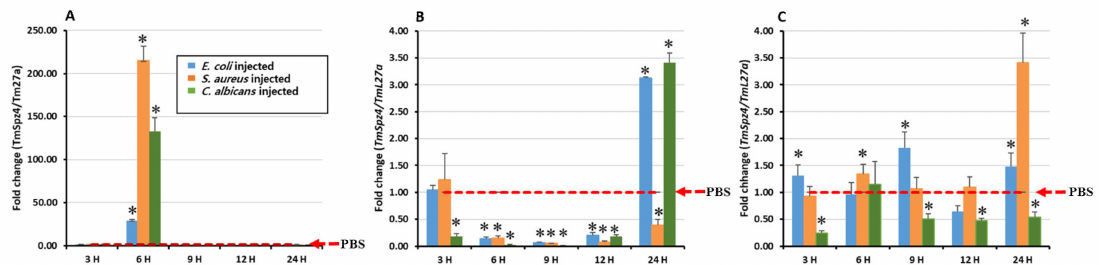
Figure 3. Induction patterns of TmSpz4 in different T. molitor larval tissues. Temporal expression was analyzed in the hemocytes ( A ), fat body ( B ), and gut ( C ) of young larvae at 3, 6, 9, 12, and 24 h post-injection with E. coli (10 6 cells / µ L), S. aureus (10 6 cells / µ L), or C. albicans (5 × 10 4 cells / µ L). Twenty young mealworm larvae were used for each time point. TmSpz4 expression levels were normalized to those in PBS-injected controls. T. molitor 60S ribosomal protein L27a ( TmL27a ) was used as an internal control. The dotted red line indicates PBS injection control. Asterisks indicate significant differences between infected and PBS injected larval group by Student’s t -test ( p < 0.05). The vertical bars indicate Mean ± SD ( n = 20).